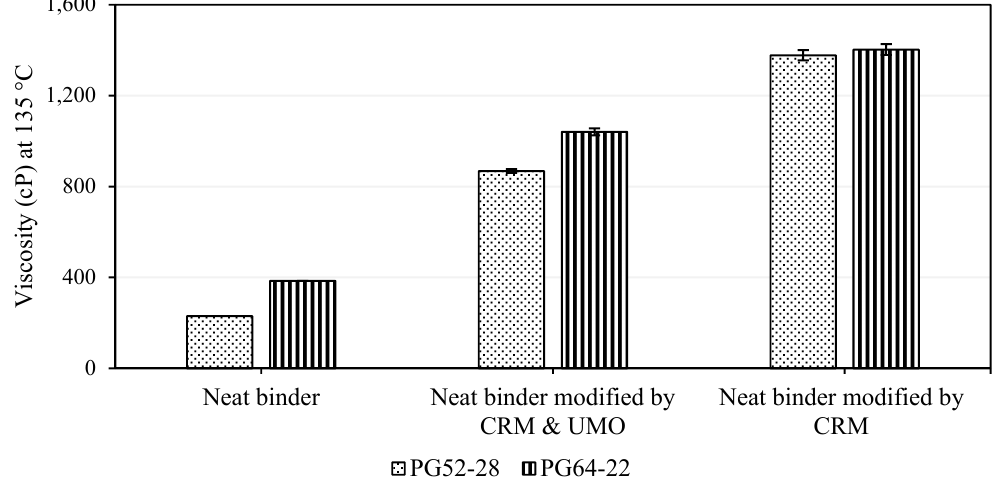
Figure 6. Viscosity of neat and modified asphalt binder samples at different interaction conditions.